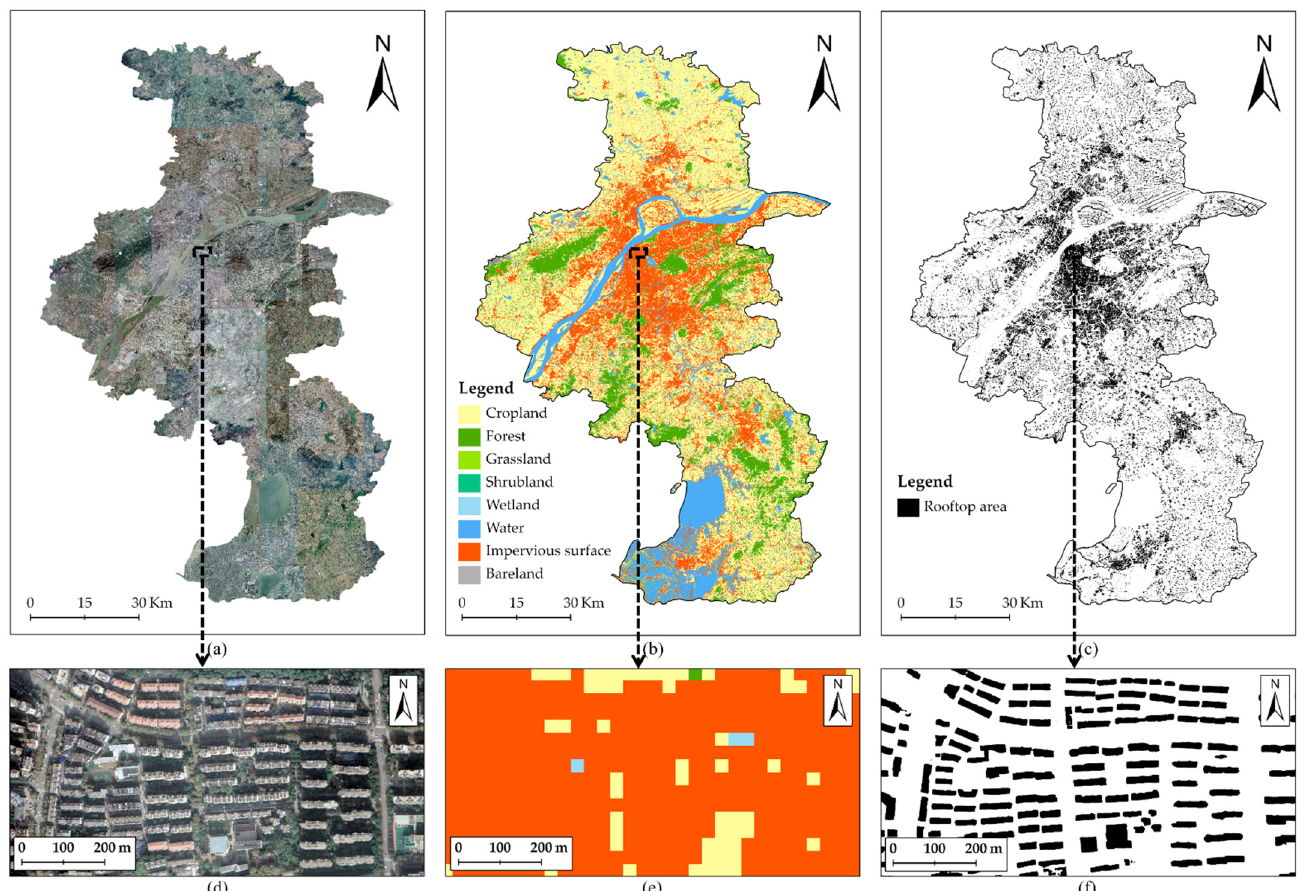
Figure 2. Datasets of Nanjing. ( a ) GES imagery, ( b ) FROM-GLC30 2017, ( c ) vectorized rooftop area, ( d ) part of the GES imagery, ( e ) part of the FROM-GLC30 2017 image, and ( e ) part of the vectorized rooftop area image.